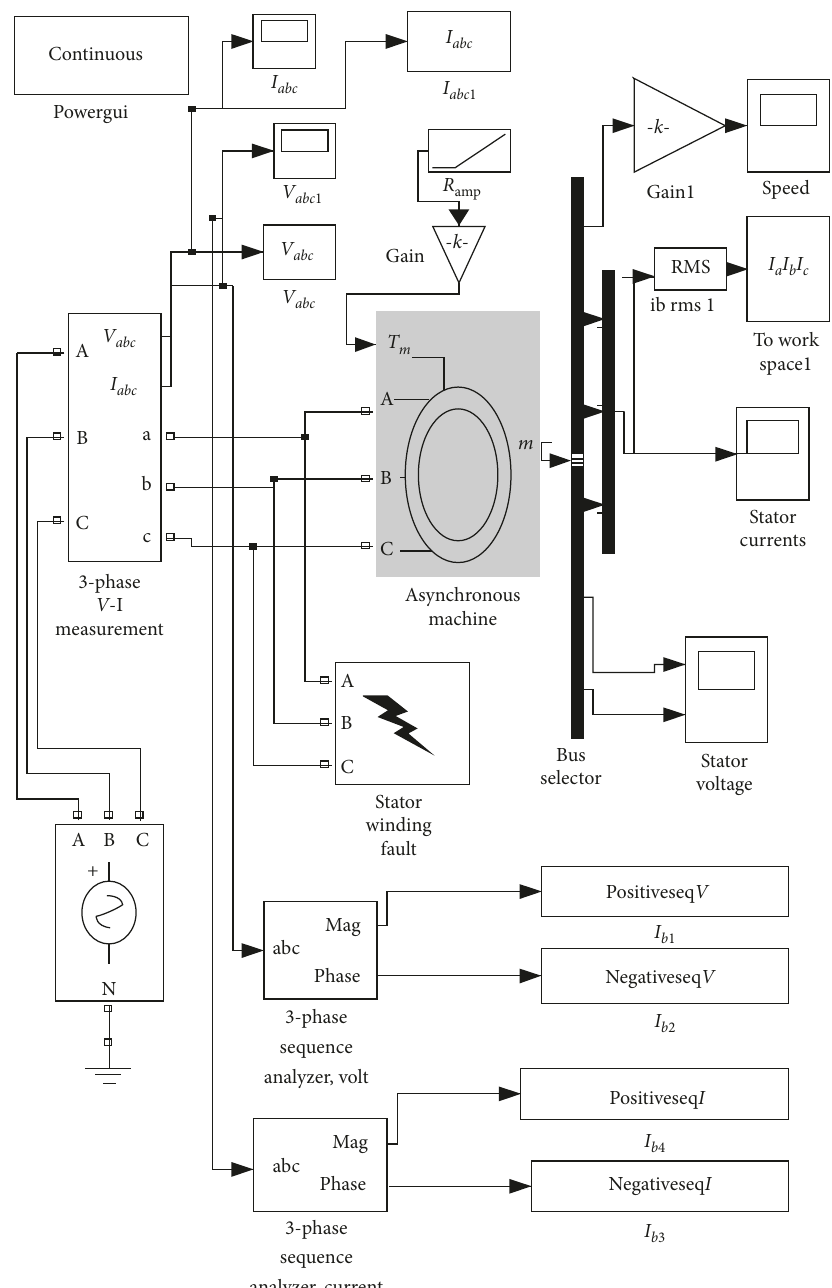
Figure 1: Simulink model for extraction of sequence components of current and